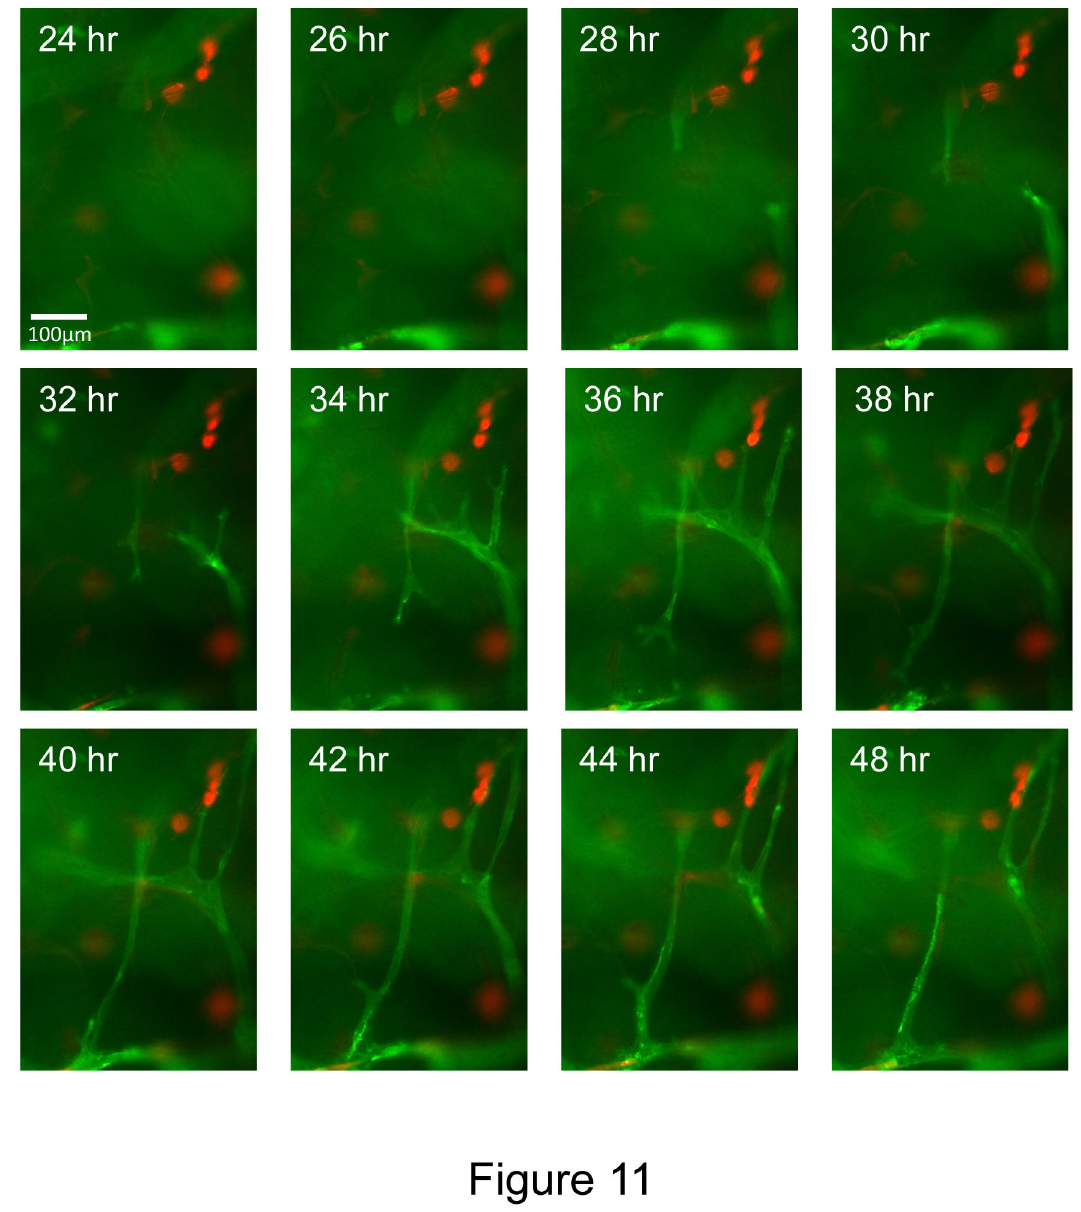
Figure 11. Time lapse images of EC sprouting and tubulogenesis in 3D fibrin matrices under serum-free defined conditions which are stimulated by hematopoietic stem cell cytokines, FGF-2 and pericytes. mCherry-pericytes, hematopoietic cytokines and FGF-2 were incorporated into the fibrin matrix, and VEGF/FGF-2 primed ECs (membrane AcGFP- labeled) were seeded onto the surface of fibrin gels and real-time movies were made. Select time points are shown from a representative field showing marked EC sprouting and tube formation as well as EC-pericyte interactions. Interestingly, it appears that EC sprouts might be preferentially orienting toward mCherry-pericytes in these movies suggesting the presence of pericyte- derived directional cues. Bar equals 100